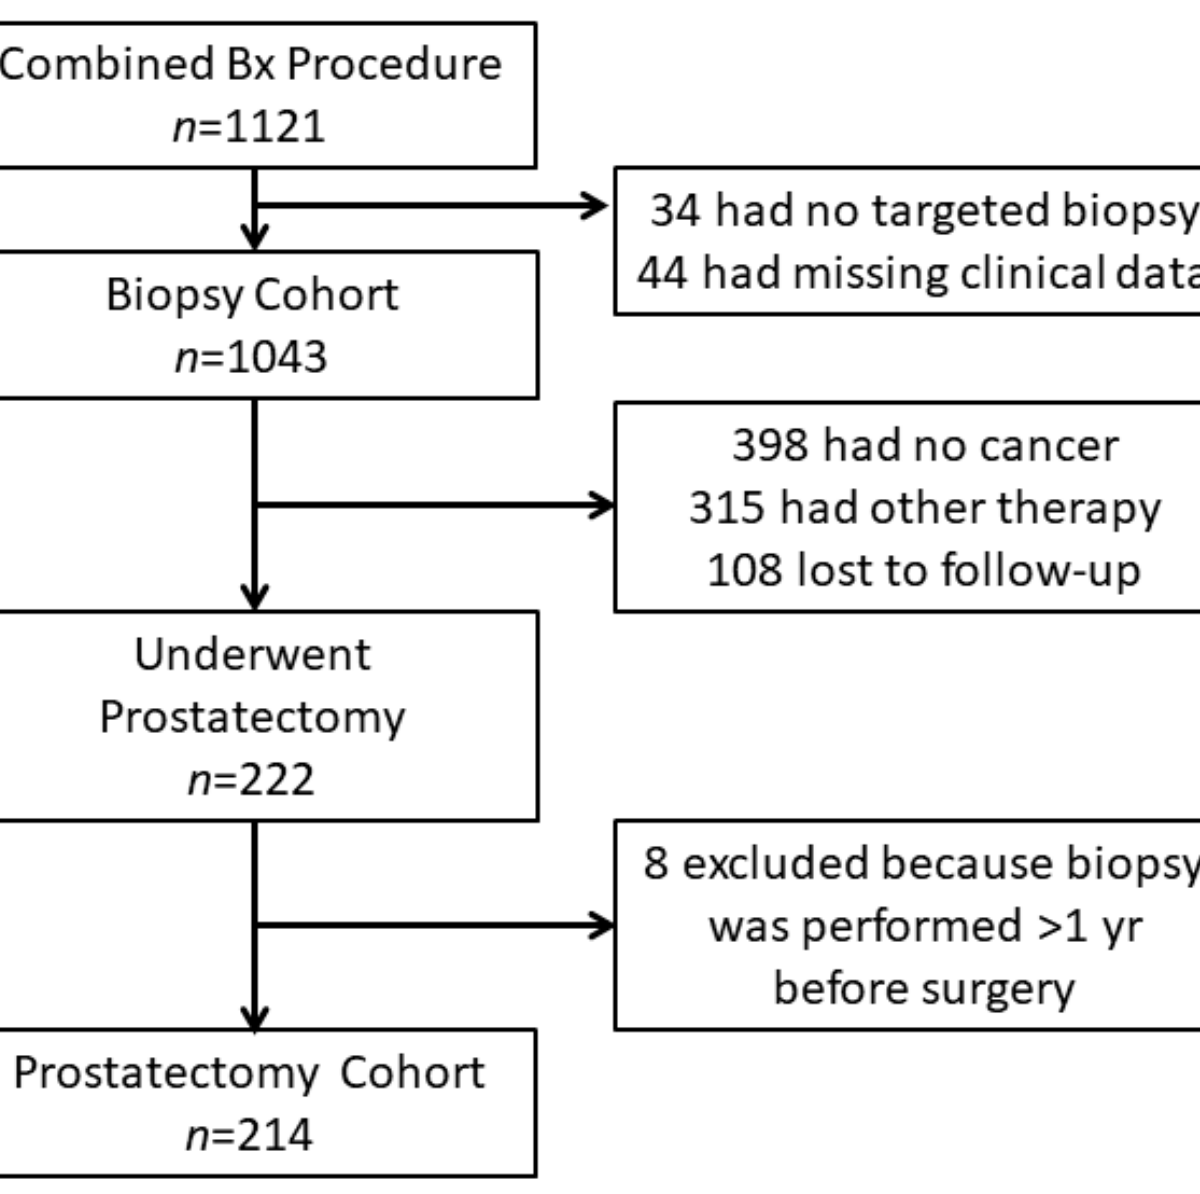
Figure 1. Enrollment and Outcomes. All included men underwent combined biopsy (Bx) procedure with a combination of MRI-targeted biopsy plus synchronous systematic biopsy. For men diagnosed with PC different treatment options were offered (active surveillance, radiotherapy, and radical prostatectomy). Men undergoing a subsequent radical prostatectomy were considered for the analysis of reclassification rates of cancer grade groups between biopsy and wholemount